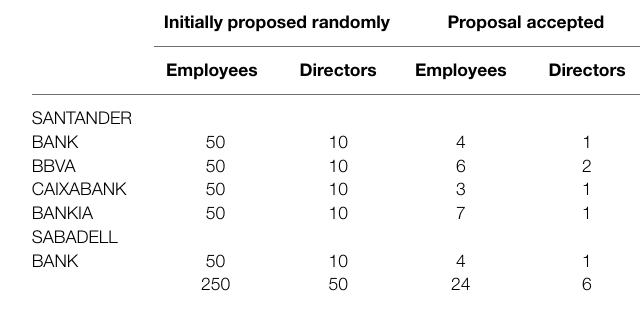
TABLE 3 | Distributions of participants in the collecting data procedure.